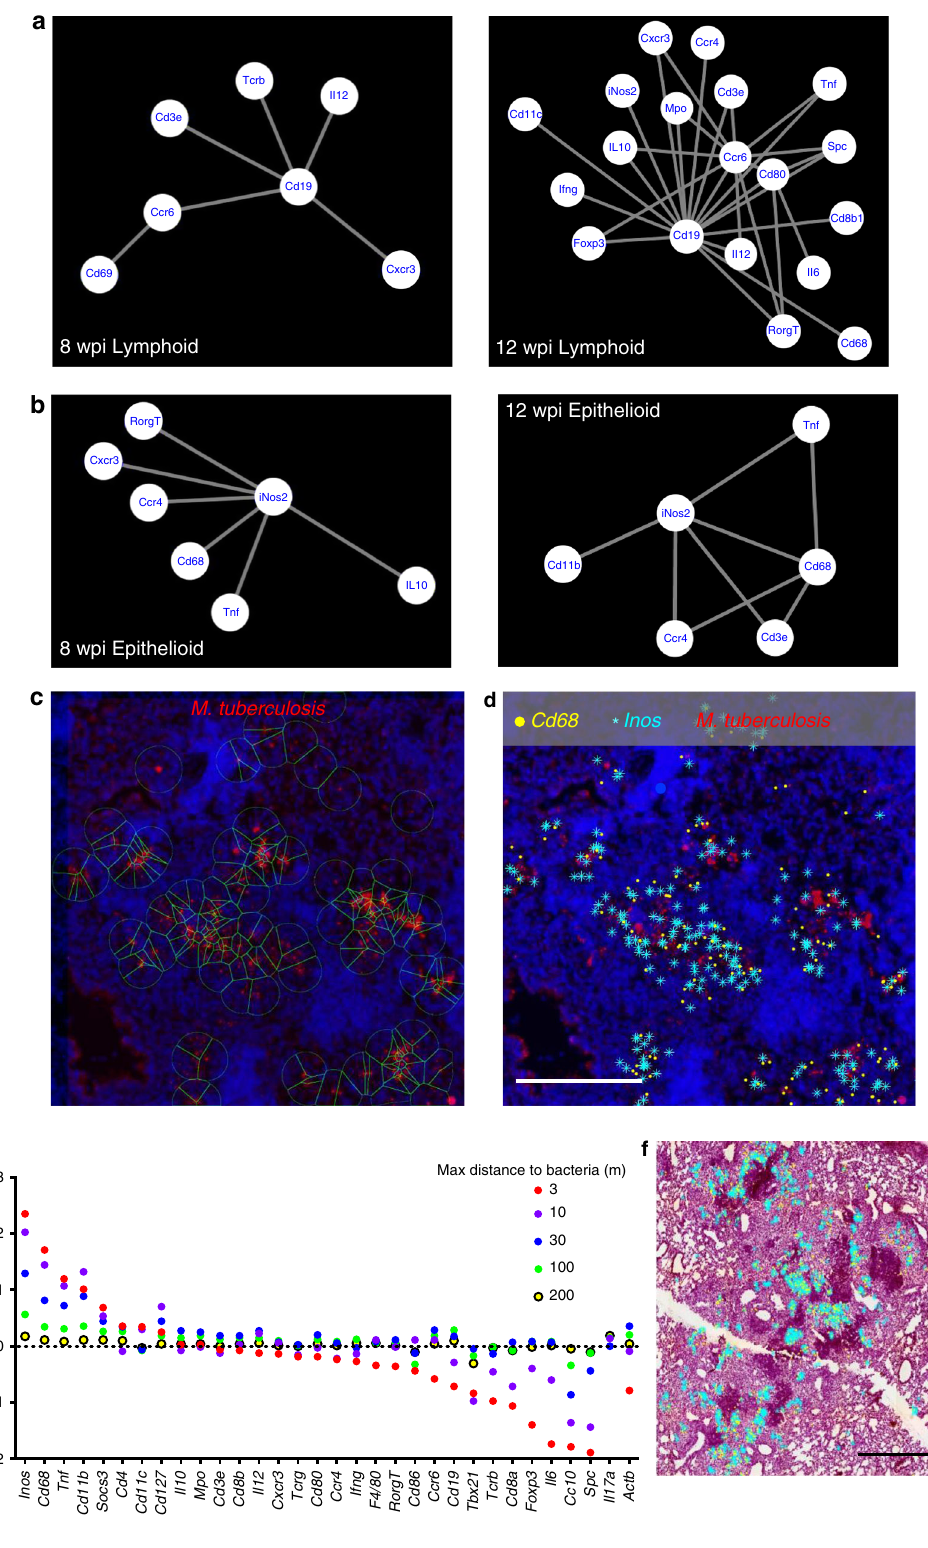
(Fig. 7b and Supplementary Fig. 6C) con fi rming previous data 15 . The center (GC) and the outline (GO) of seven large encapsulated granulomas, fi ve non-organized perivascular cellular lesion with high density of lymphocytes and epithelioid cells, with pockets of intracellular bacteria (non-organized granuloma, NOG) (Fig. 7a